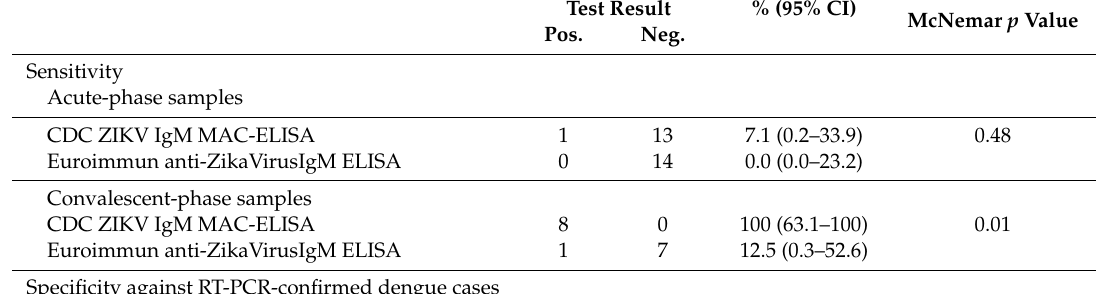
Table A1. Evaluation of the accuracy of the CDC IgM Zika MAC-ELISA compared to the Euroimmun anti-Zika Virus IgM ELISA on the same set of acute- and convalescent-phase samples from RT-PCR-confirmed Zika patients, RT-PCR-confirmed dengue patients, and of blood donor samples from Salvador,